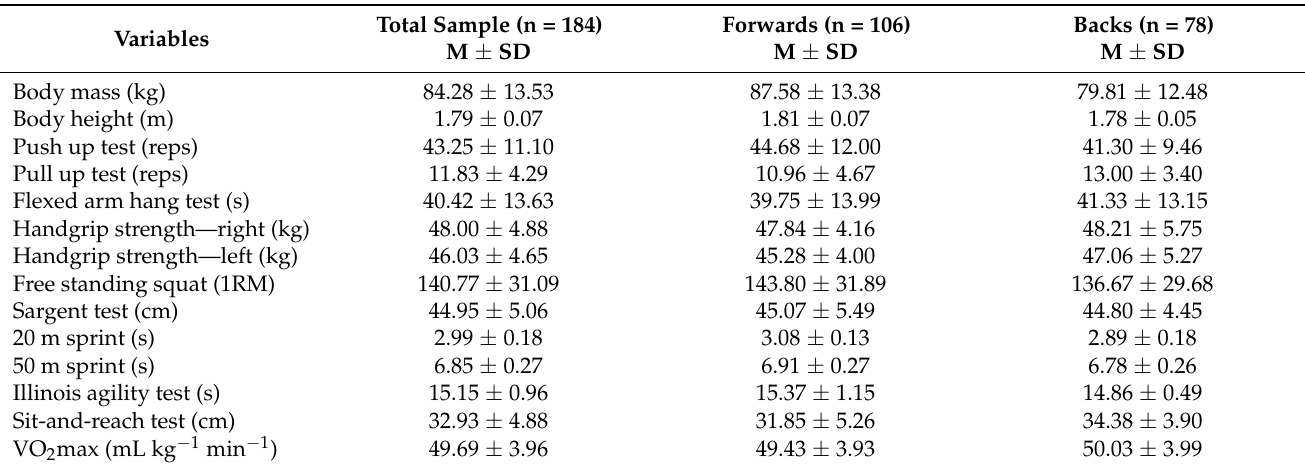
Table 1. Descriptive statistics of the anthropometry characteristics and physical fitness performance measures for the total sample and for playing positions.